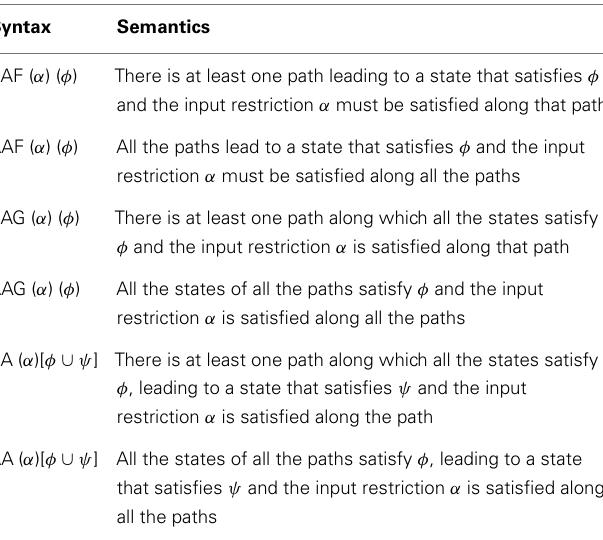
Table 1 | Syntax and semantics of the mainARCTL temporal operators [for a complete description see Lomuscio et al. (2007)]